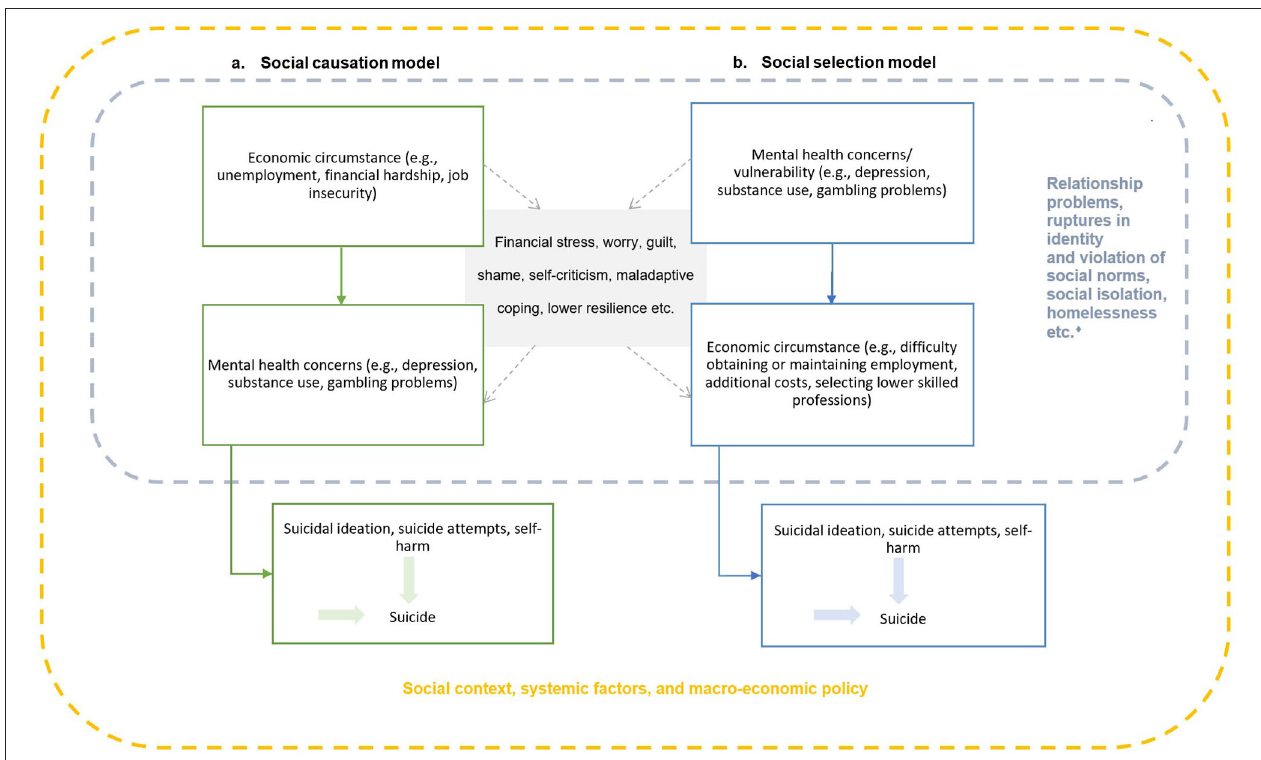
FIGURE 1 | The social causation and social selection theoretical models that account for economic circumstance, mental health, and suicidal behavior. The diamond symbol correlates for suicidal behaviors that may influenced by economic factors and mental health through social causation or selection (may interact differently due to other socio-demographic variables such as